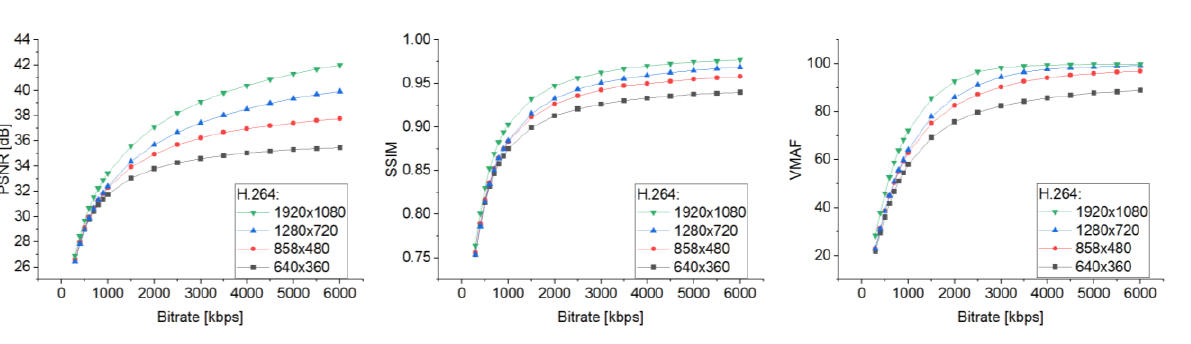
Figure 14. Relationship of the objective assessment of video quality encoded in the H.264 standard vs. bit rate for the resolutions 640 × 360, 858 × 480, 1280 × 720, and 1920 × 1080.